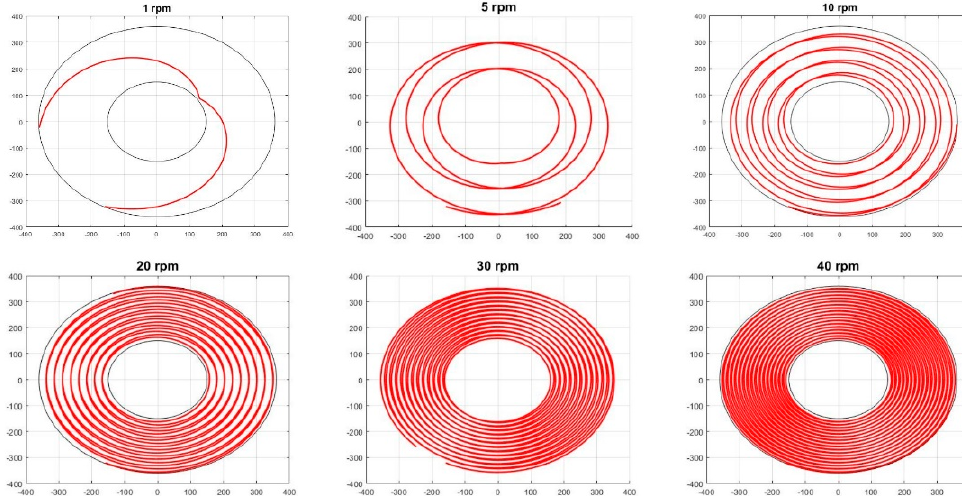
Figure 6. Diagram of scanning locus by different pad speed.